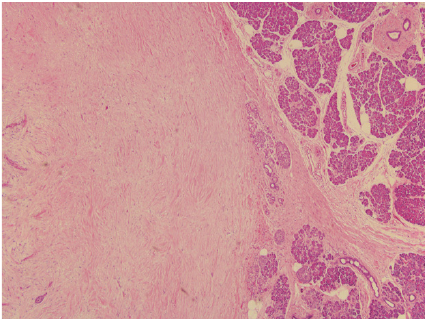
Figure 3: Histology of the resected tumor at a magnification of 40x showing abundance of elastic fibers.